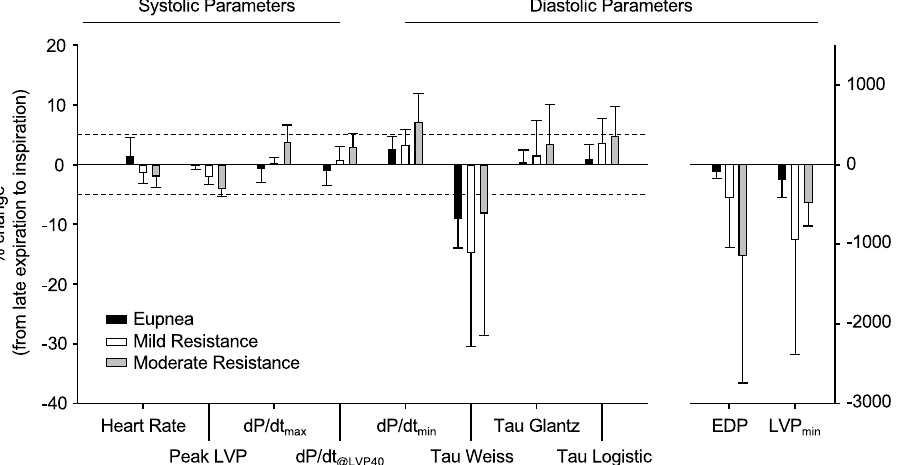
Figure 6. Diastolic parameters are more heavily influenced by inspiration than systolic parameters. Zero identifies the value specific to each parameter at the late expiratory phase of respiration. Vertical bars represent the percentage by which each parameter changes during inspiration from late expiration. Cardiac parameters are shown during eupnea (black), mild resistance (white), and moderate resistance (grey). Dotted horizontal lines are ± 5. Data are presented as mean ± SD, n =